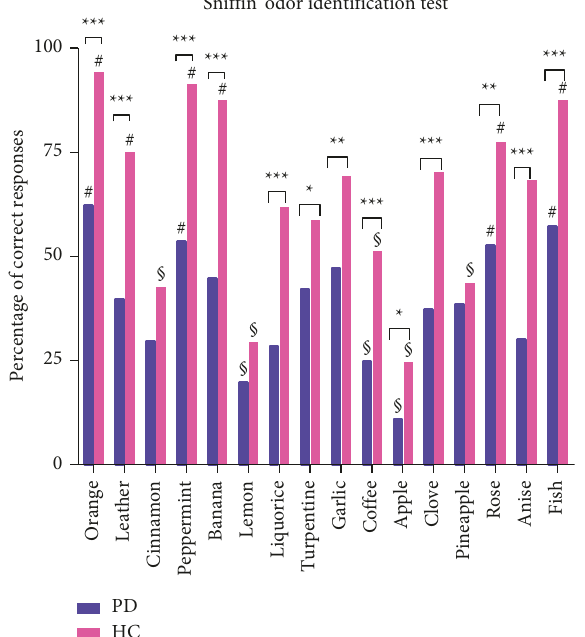
Figure 1: Responses of Parkinson’s patients and healthy controls for the Sniffin’ Sticks odor identification test; HC, healthy controls; PD, Parkinson’s disease patients; ∗ p < 0.05; ∗∗ p < 0.01; ∗∗∗ p < 0.001; # an odorant that is better recognized compared with the other odorants within the specific population group; §, an odorant that is least recognized compared with the other odorants within the specific population group.